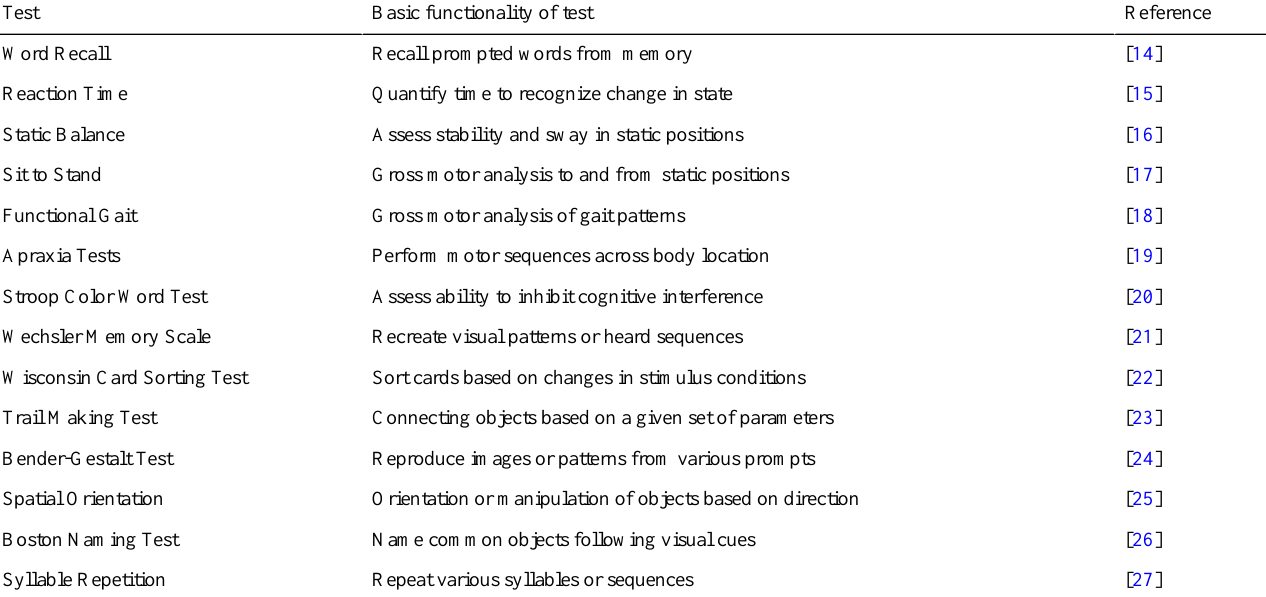
Table 2. Test types and their functionalities.